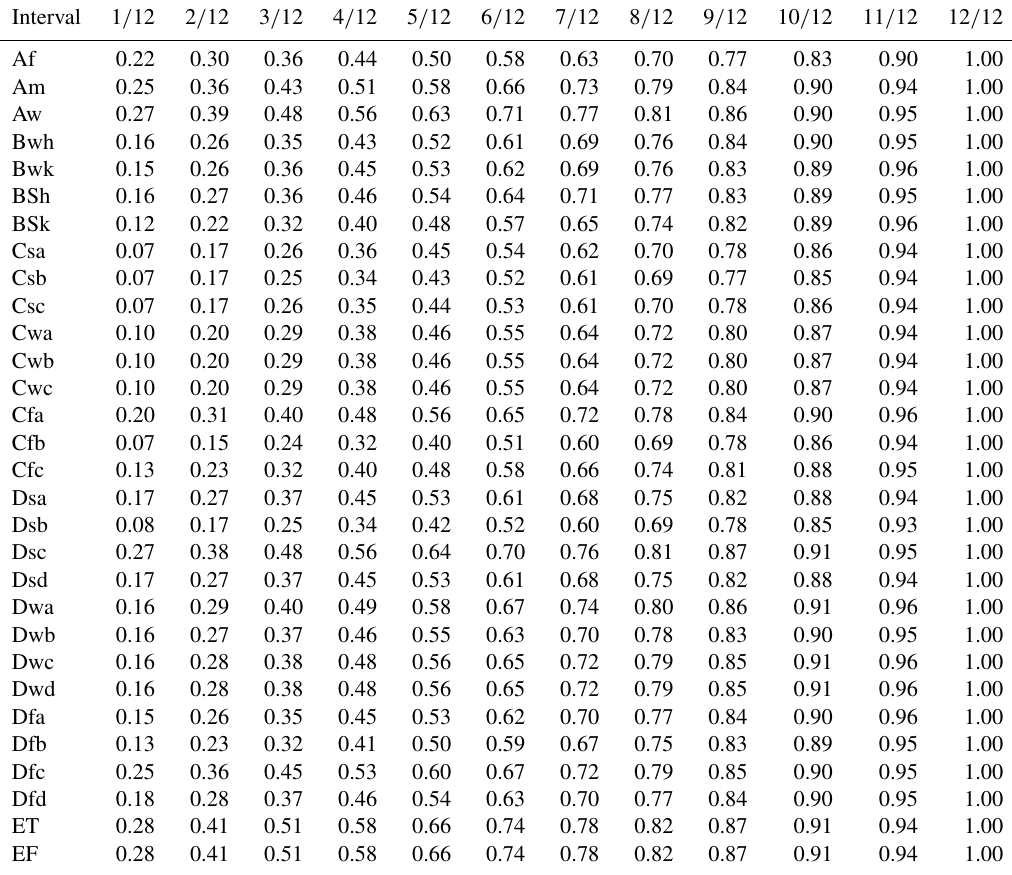
Table A1. TimePk distribution interval values for global Köppen–Geiger climate classifications.